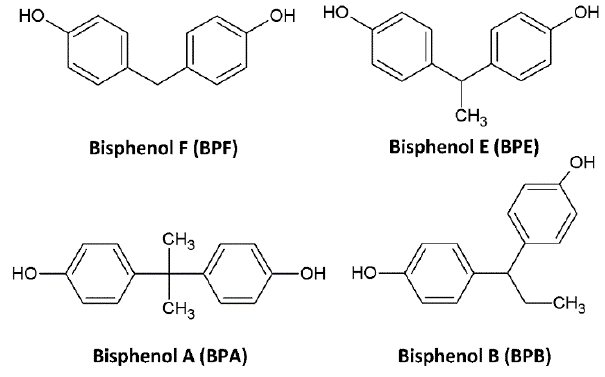
Figure 1. Structures of the analyzed bisphenols.